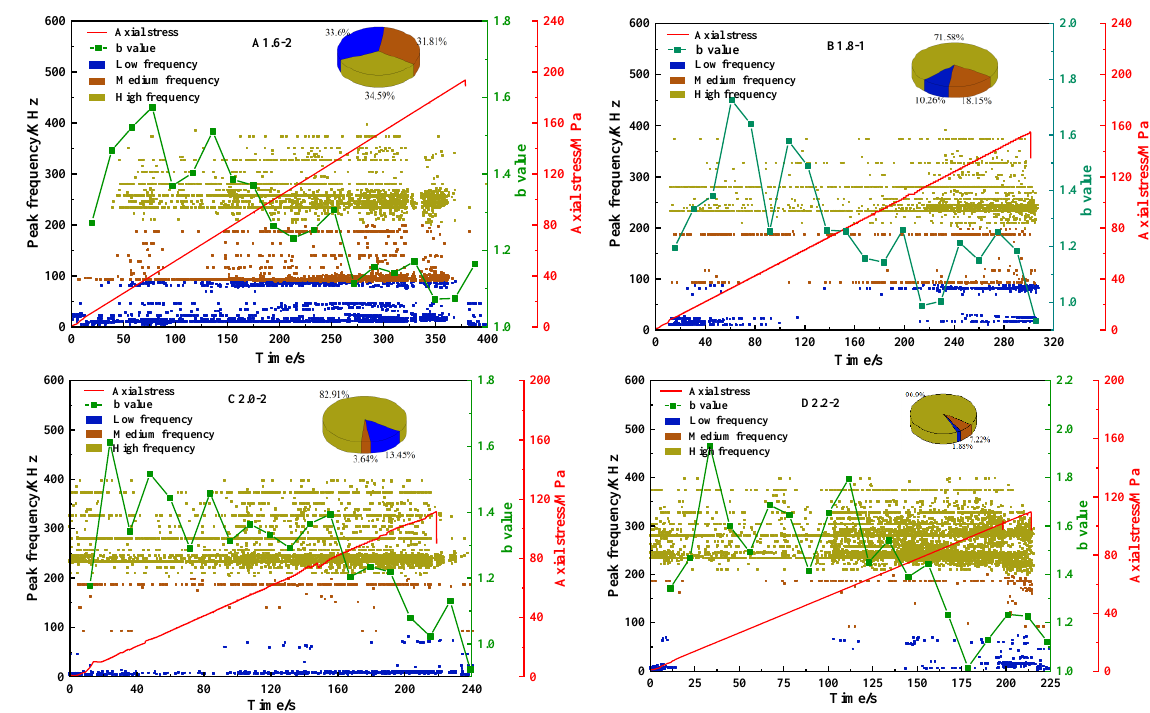
Figure 9. Peak frequency-b value-axial stress- time curve of rock samples with different height−diameter ratios.